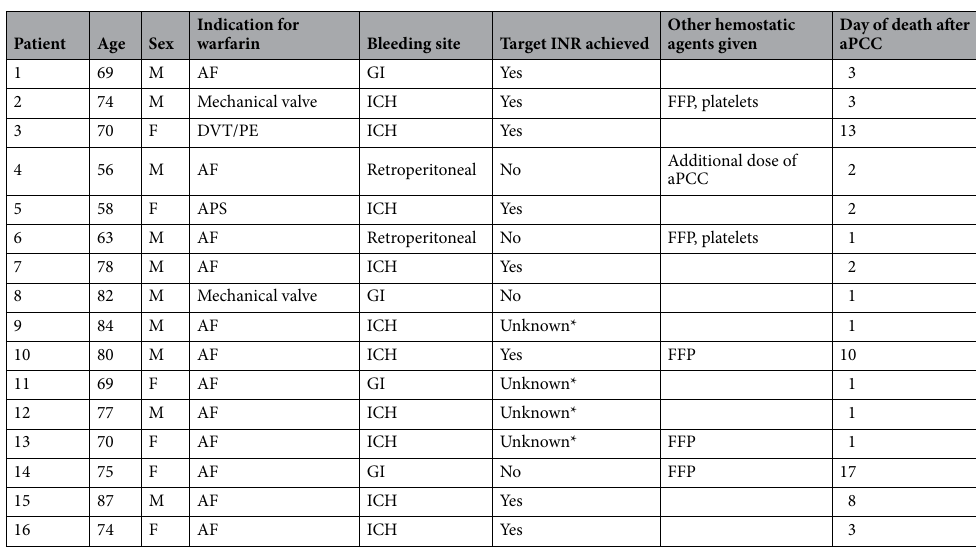
Table 4. Details of deaths during hospitalization. AF atrial fibrillation, APS antiphospholipid syndrome, DVT deep venous thrombosis, FFP fresh frozen plasma, GI gastrointestinal, ICH intracerebral hemorrhage, PE pulmonary embolism. *Patient died before repeat